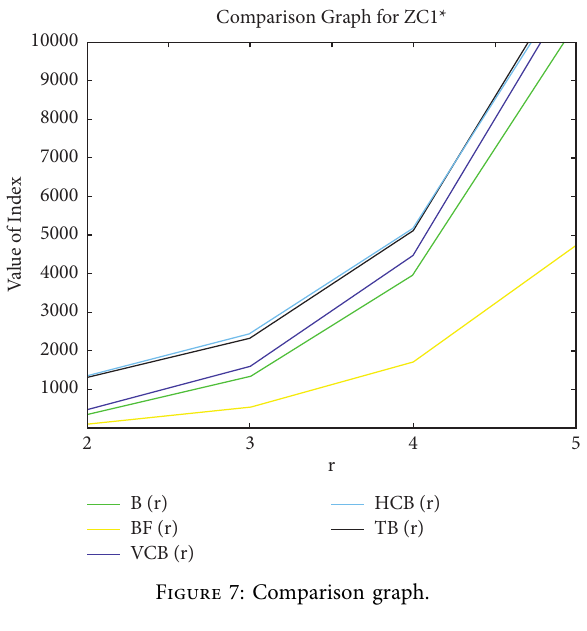
Figure 7: Comparison graph.